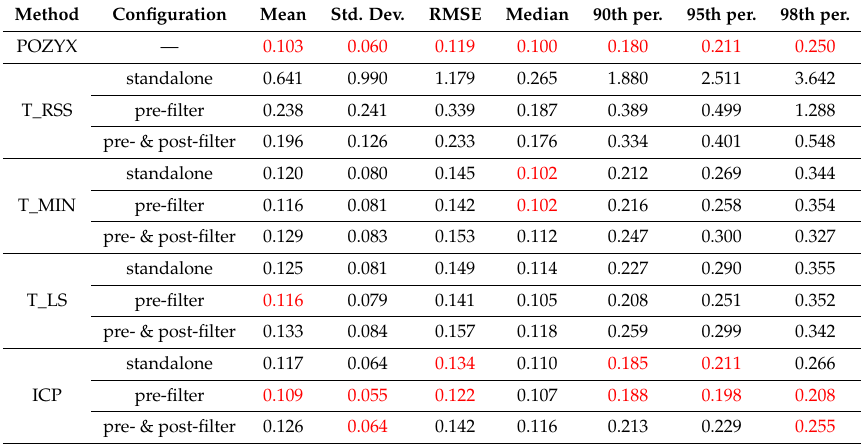
Table 4. Performance data for the rectangular trajectory with changes in height. Values in red denote the three best values for each metric. All values are in